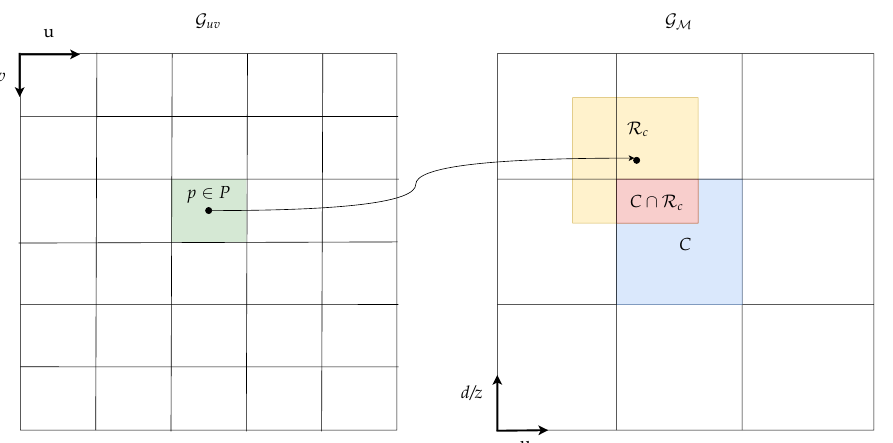
Figure 3. Mapping of measurements with assigned object labels from image to u-disparity/- depth